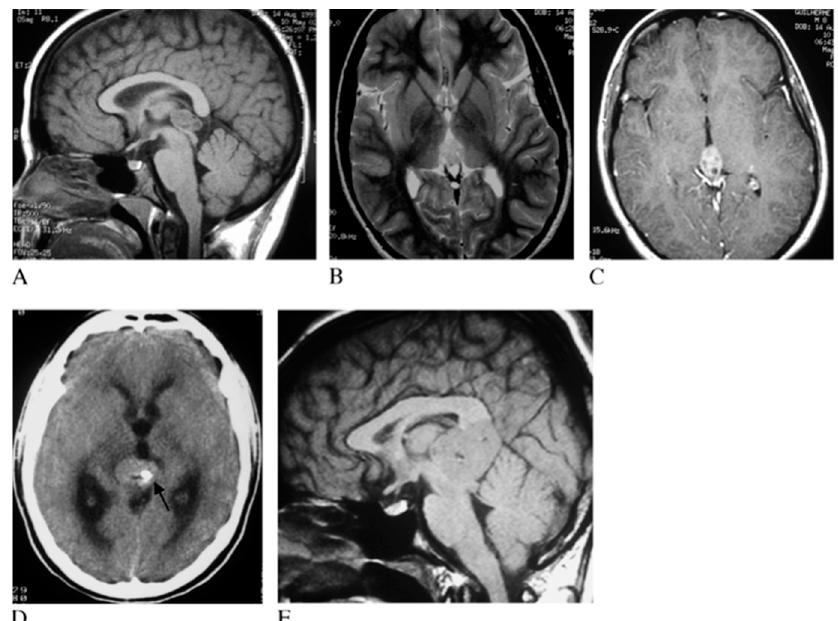
Figure 3. Pineal germinoma magnetic resonance imaging (MRI). Pineal tumor hypointense on T1 weighted image (T1WI) ( A ), hyperintense on T2WI ( B ) and with homogeneous contrast enhancement ( C ). The arrow identifies hyperdense mass with calcification at computed tomography ( D ). In another patient, a larger germinoma, isointense on T1WI ( E ). Reprinted with permission from Reis et al. (2006) [41]. John Wiley and Sons—2021 (License Number 5034711197310).